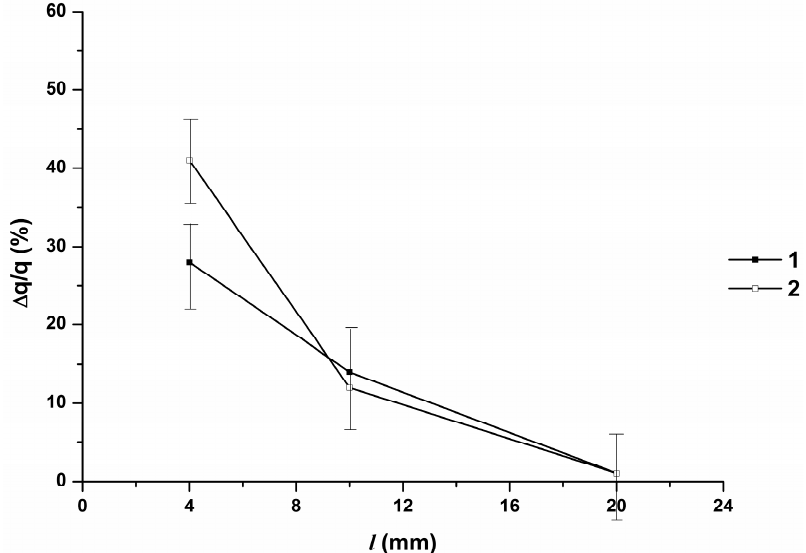
Figure 4. The dependencies of the relative change in the value of charge ( ∆ q/q ), generated in water, on the distance between the injector nozzle and the investigated material: mica (1) or highly oriented pyrolytic graphite (HOPG) (2). T = 35 °C.